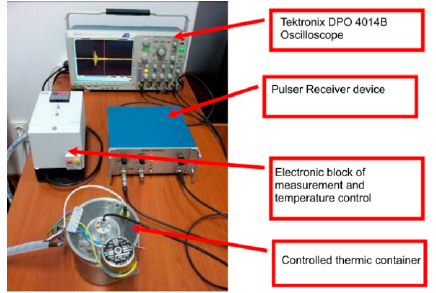
Figure 1. Overview of the chain of measurement.